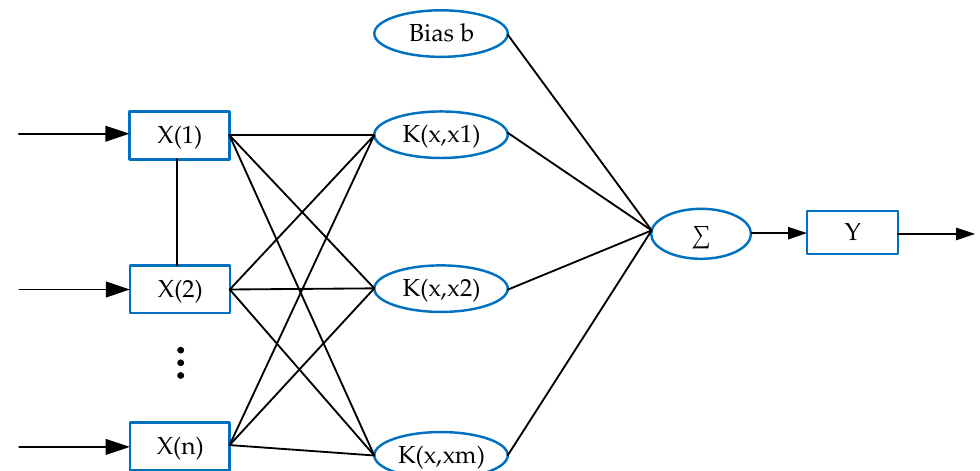
Figure 2. The structure of the support vector machine algorithm. When SVM is used as a continuous value regression tool, it is called support vector regression (SVR). SVR needs to find a hyperplane, similar to SVM. The difference is that SVM needs to find a hyperplane with the largest gap. In SVR, a threshold ε needs to be defined, and only the loss of the data points in the strip area as shown in Equation (5) is calculated, and then the points outside the area are